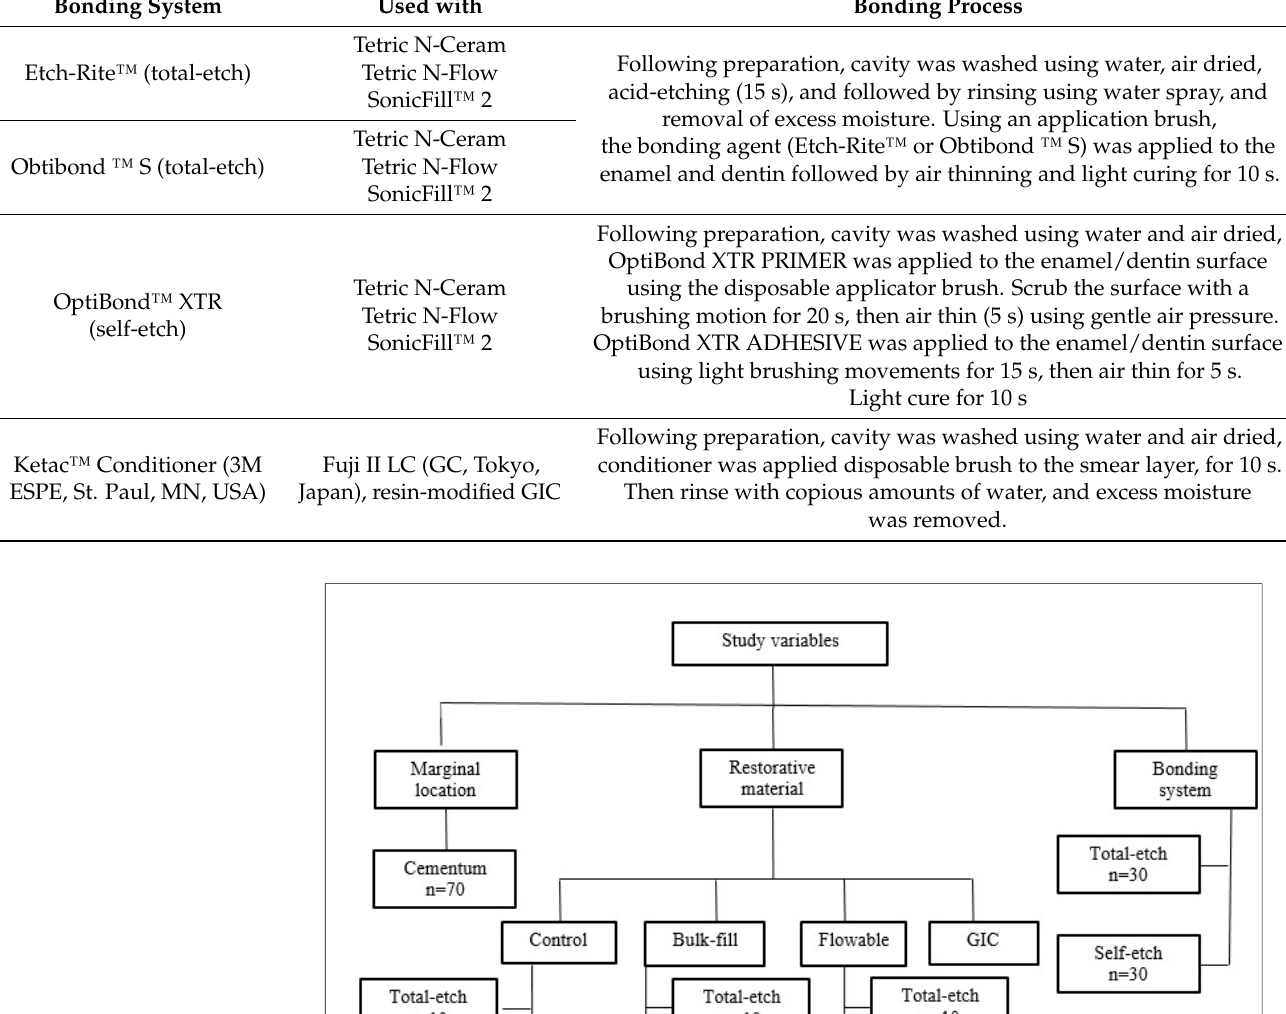
Table 2. Description of various bonding processes employed in the study.